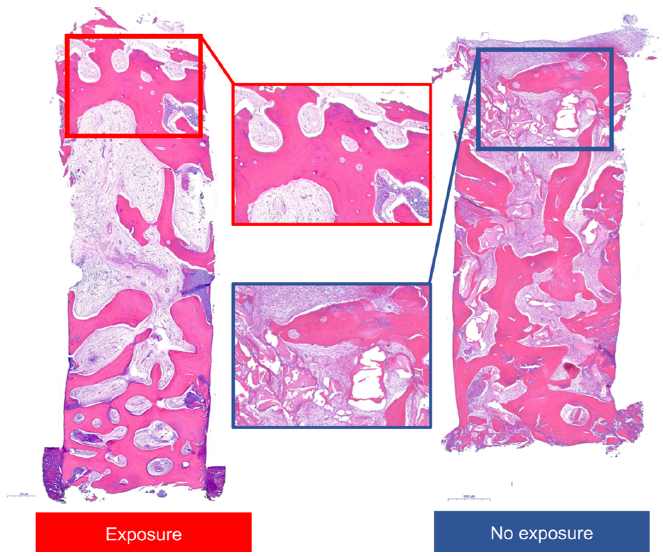
Figure 6. Histologic views of representative specimens with or without exposure. Images represent entire and high-magnification